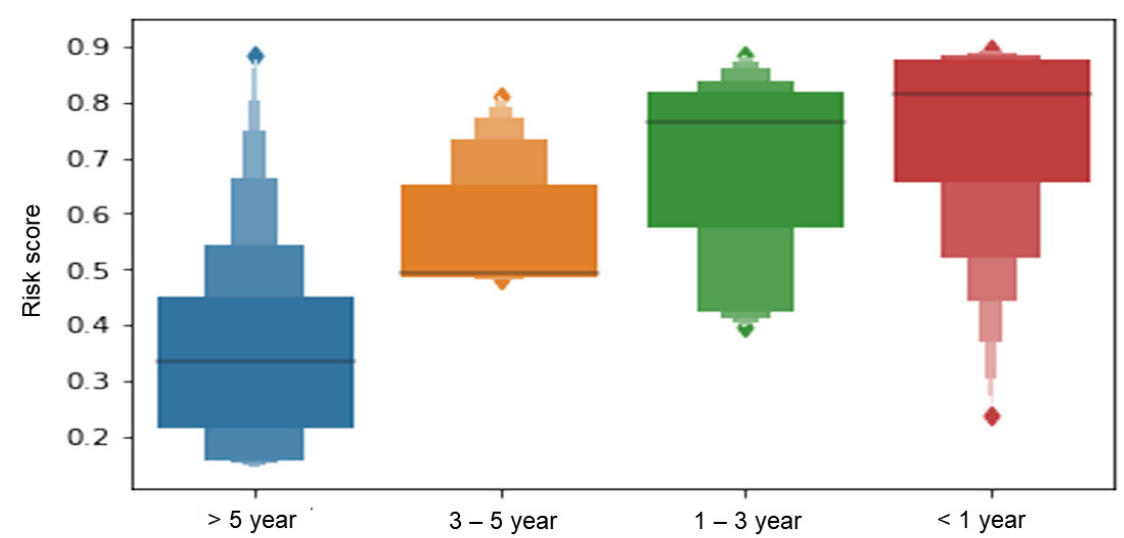
Figure 4. The Boxen plot of case probability by criteria of early intestinal resection using a training set of the final model. The case probability is expressed in the form of a Boxen plot.